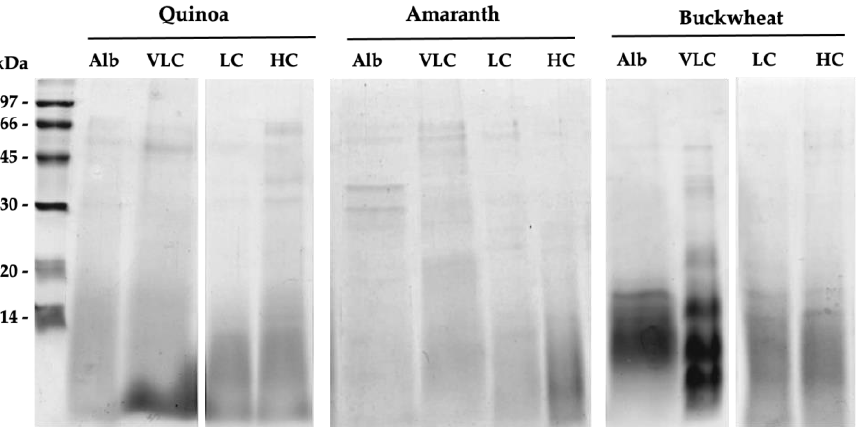
Figure 2. SDS-PAGE analysis of albumins and globulin fractions after simulated gastro-intestinal digestion. Alb: albumin fraction; VLC: very low-charge globulins; LC: low-charge globulins; HC: high-charge globulins.